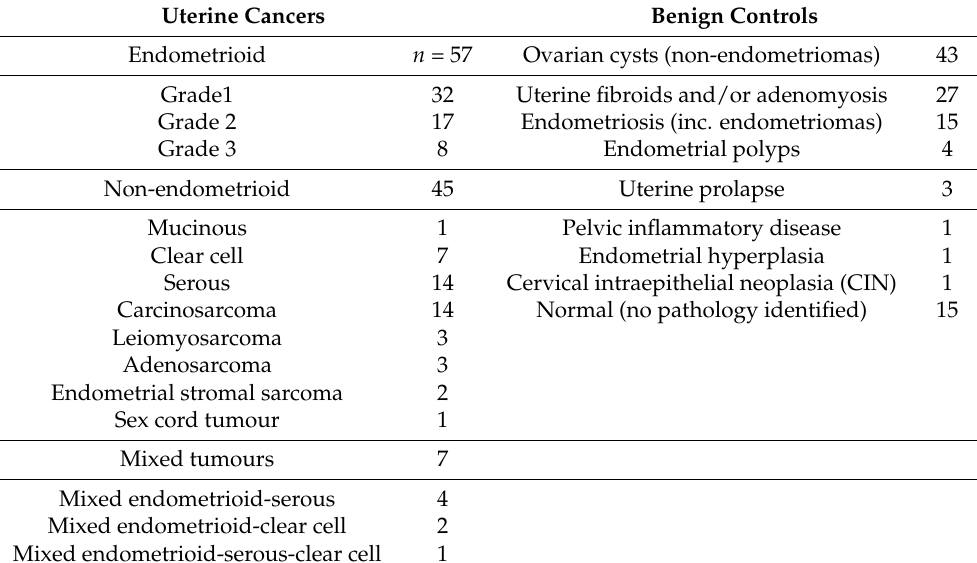
Table 2. Histopathological data for the study